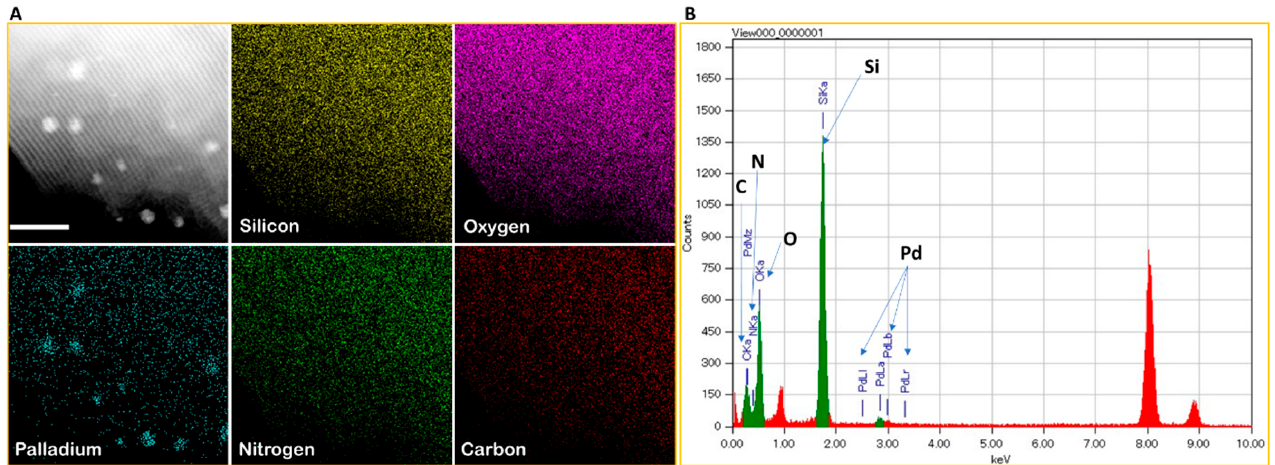
Figure 5. ( A ) HAADF-STEM image and elemental TEM-mapping images of every element in a separate image related to Pd@MO-ISO. Scale bar shows 100 nm and is constant for all images. ( B ) TEM-EDS spectra of Pd@MO-ISO.